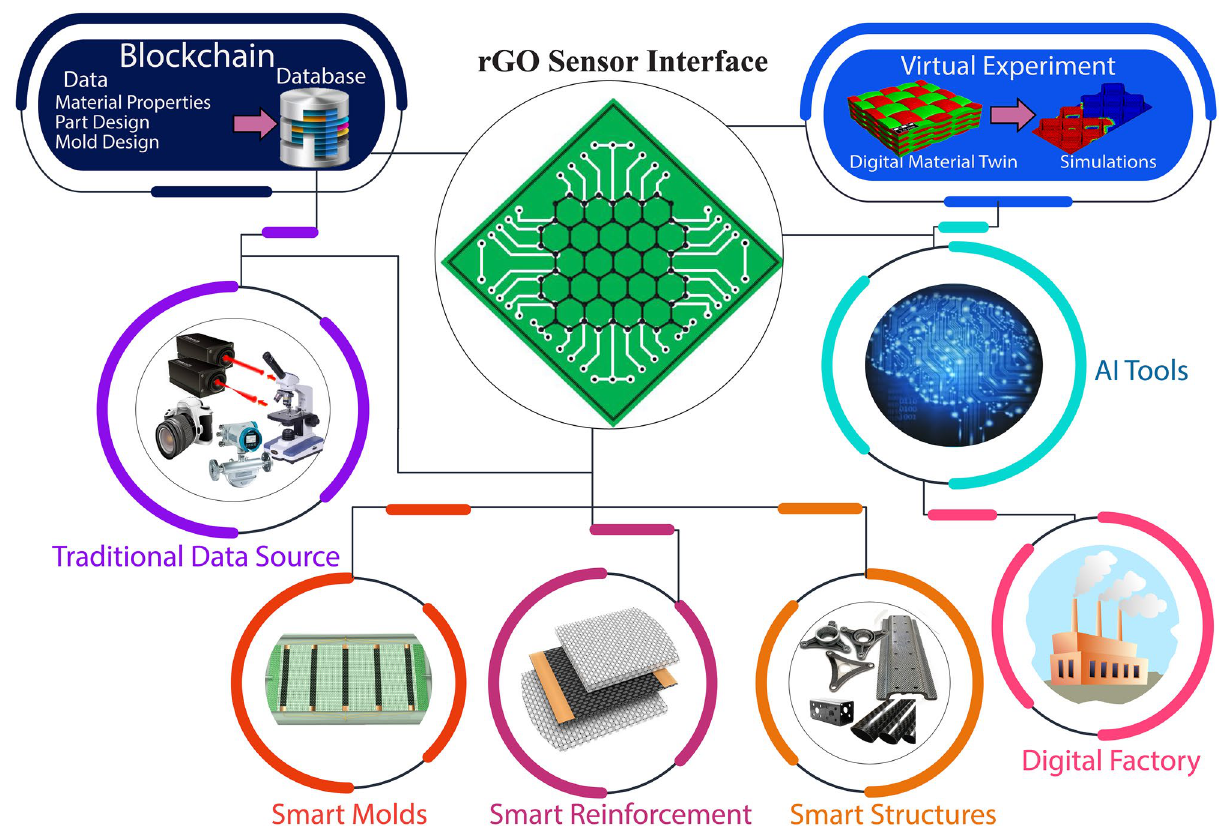
Figure 1. Flow chart illustrating the digitalization of composite structures using graphene nanoparticles as interface for creating a digital factory environment. Reduced Graphene Oxide based sensors along with traditional sensors can be incorporated in the manufacturing setup for digital manufacturing. Using the advanced tools such as block-chain technology, artificial intelligence, virtual simulations and digital twins, smart manufacturing can be achieved within Industry 4.0